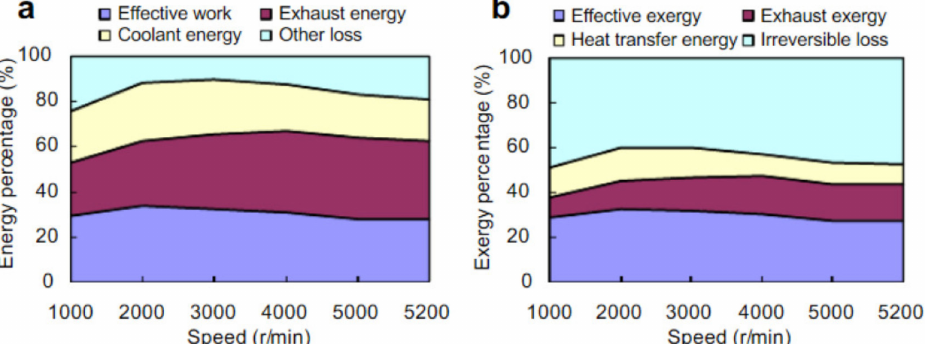
Figure 6. Energy ( a ) and Exergy ( b ) Distributions of a Turbocharged direct injection gasoline (GDI) Engine.